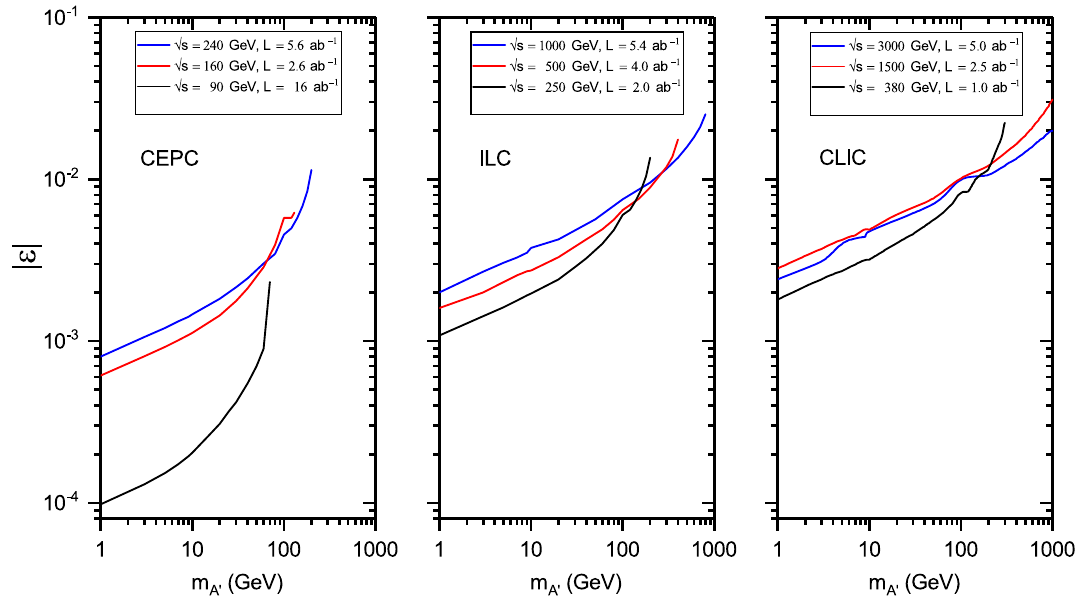
Fig. 9 The excluded bounds at the 95% CL on the dark photon mass m A (cid:2) and kinetic mixing parameter ε for the invisible dark photon production in the unpolarized γ e − → A (cid:2) e − collision